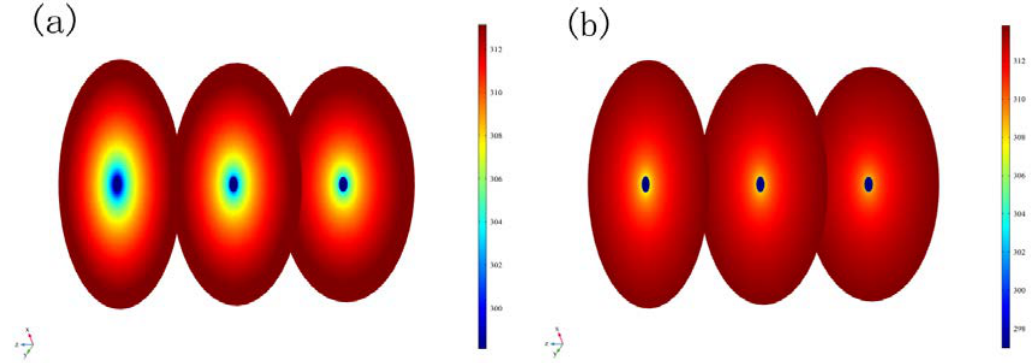
Figure 8. Comparison chart of thermal insulation effect of supporting materials (cross section): ( a ) cloud diagram of the temperature field of the concrete support roadway; ( b ) cloud diagram of the temperature field of the roadway supported by the test specimen XX45 insulation material.